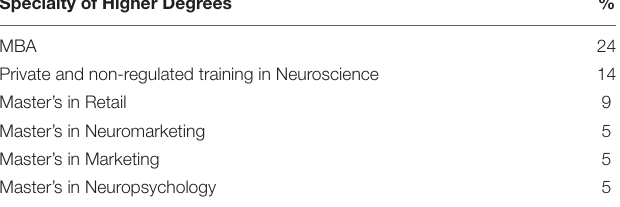
TABLE 5 | Specialties of higher